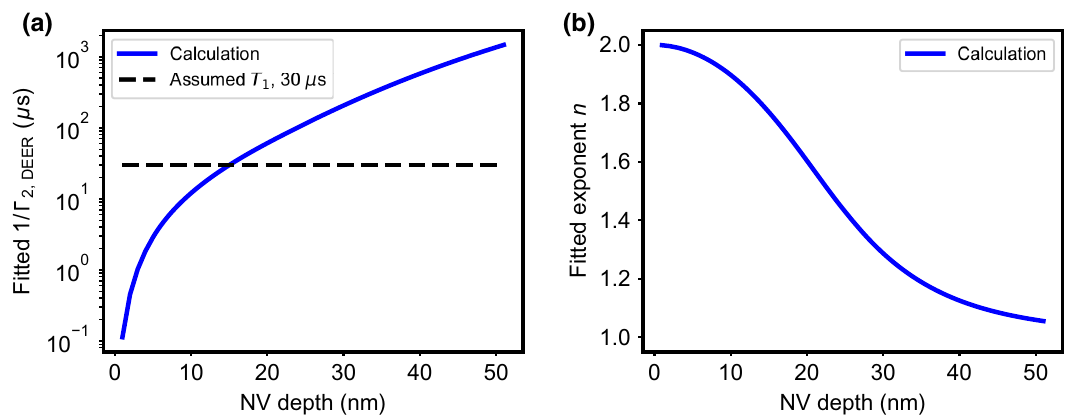
FIG. 14. Depth scaling in the presence of finite surface spin T 1 time. (a) Calculated decay timescale T 2,DEER with decay profile calculated using Eq. (F1) and fit to exp ( − (τ/ T 2,DEER ) n ) , assuming a finite surface spin T 1 time of 30 μ s (black dashed line) and a density 0.005 nm − 2 . (b) Fitted exponent n . Once T 2,DEER becomes longer than the surface spin T 1 relaxation time, n decreases from the infinite- T 1 limit of n = 2 toward the Markovian limit of n = 1. The calculated increase of n for shallower NV centers is opposite of the observed trend versus depth in Fig. 2(c) of the main text, and suggests that the depth trend in Fig. 2(c) is not explained by the effects of finite relaxation